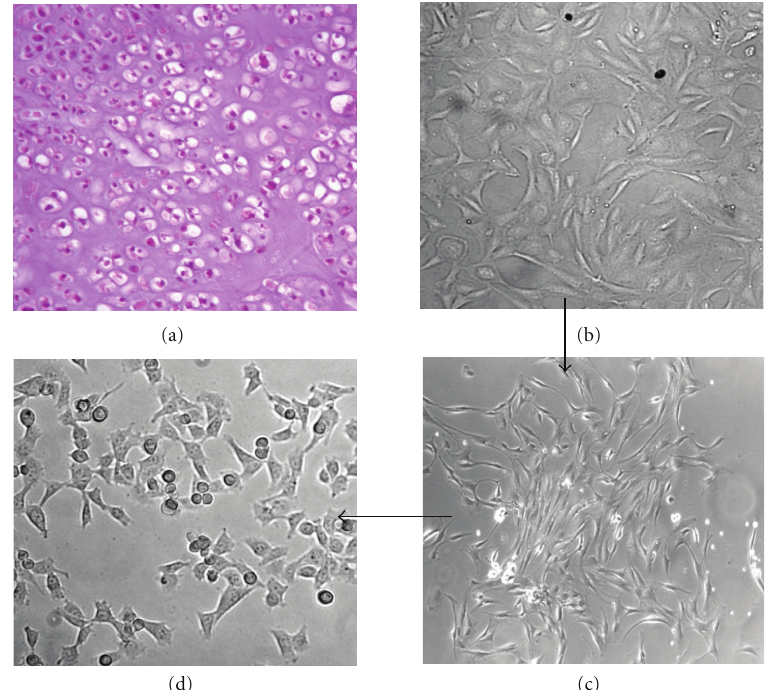
Figure 2: Generation of a primary cell culture from a chondrosarcoma tissue. (a) Haematoxylin/eosin stained section of a human primary grade 2, focally grade 3 chondrosarcoma of sternum (patient no. 6). (b–d) A representative sample from the tumor excision was subjected to enzymatic digestion. The isolated cells, recovered by centrifugation at 1500rpm, were cultured in DMEM 10% FBS until to the third passage. At this passage, cell population showed an evident cellular heterogeneity (b). Subcloning of the isolated cell clusters (c) and amplification for six further passages resulted in an adherent, homogeneous cell population characterized by small, chondrosarcoma-like cells (d). Images were captured by an inverted microscope connected to a video camera. Original magnification: x200 (a and c), x400 (b and